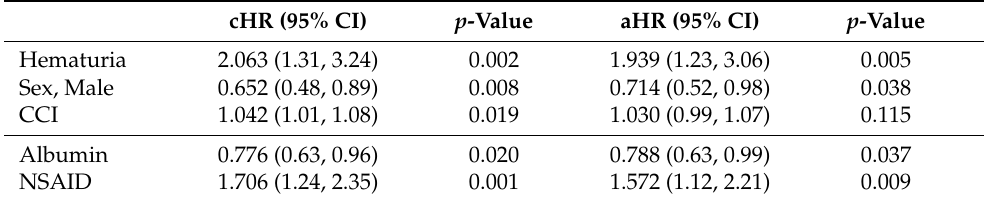
Table 3. Effects of hematuria on a 30% decline in eGFR during a five-year follow-up.